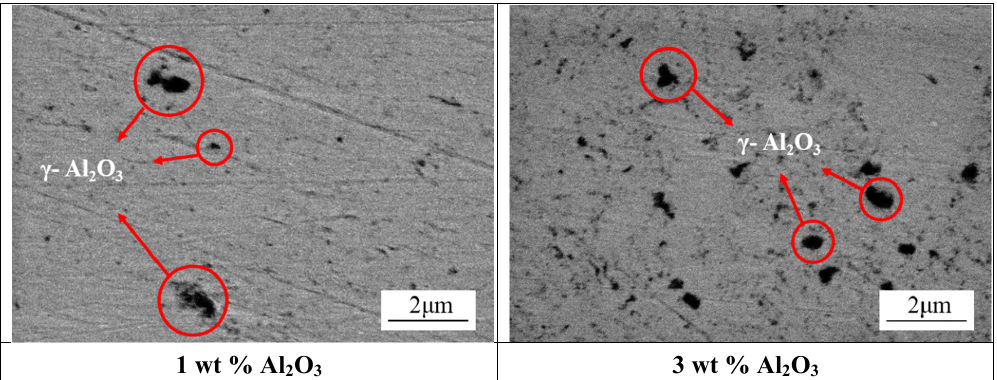
Figure 2. XRD patterns of γ -Al 2 O 3 -doped Bi 0.4 Sb 1.6 Te 3 bulk specimens. ( a ) 1 wt % Al 2 O 3 ; ( b ) 3 wt % Al 2 O 3 .